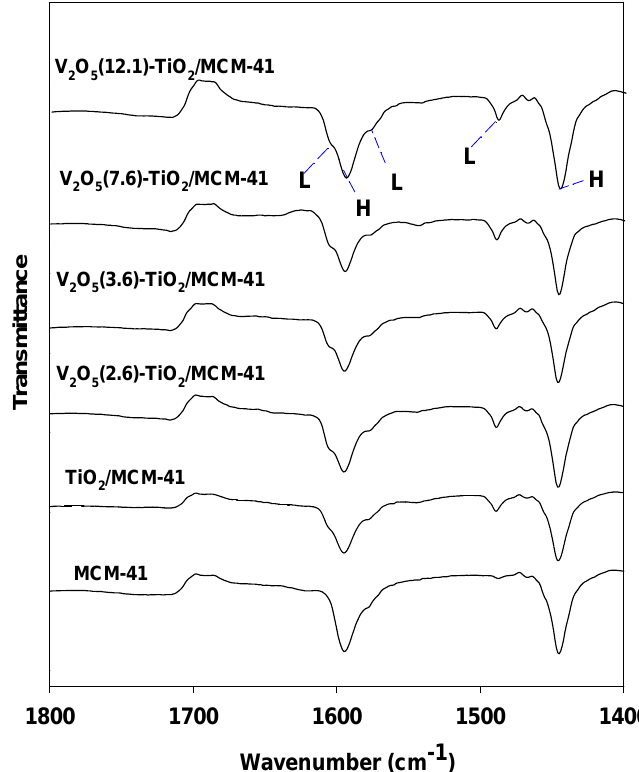
Figure 6. FT-IR of adsorbed pyridine over various samples (150 °C, 10 − 3